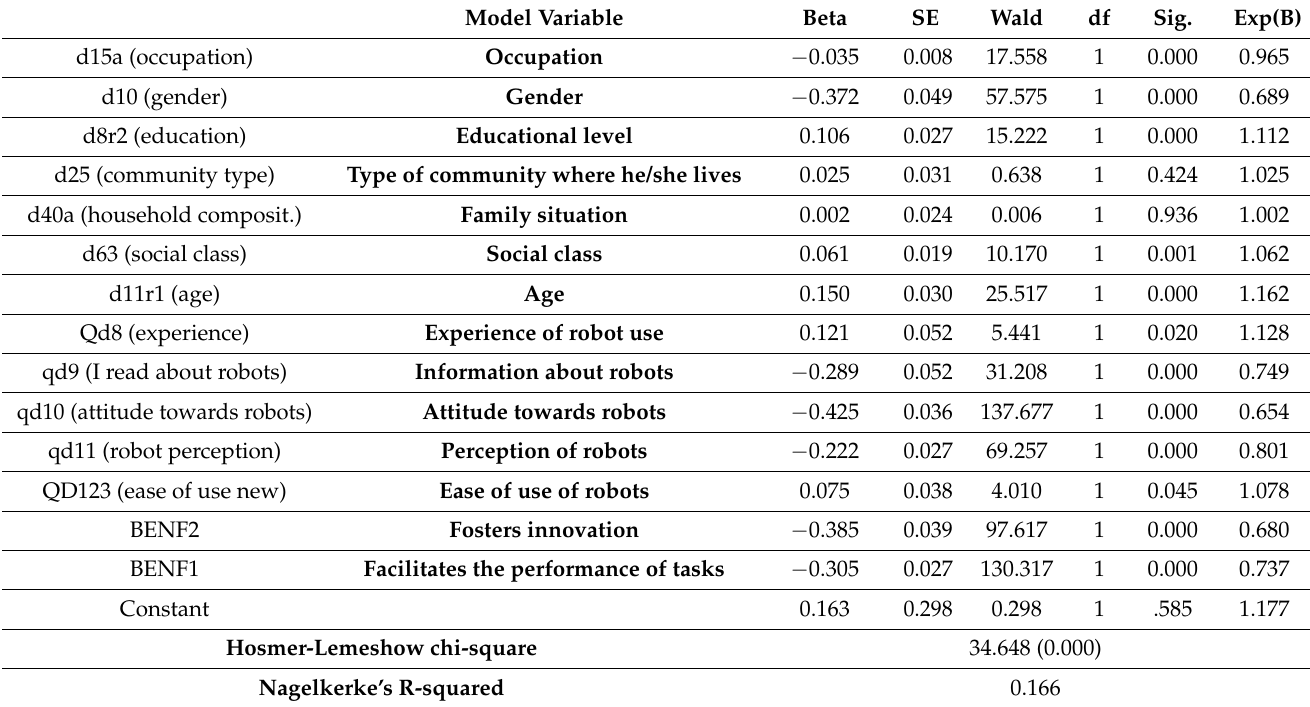
Table 3. Results of logistic regression for the sample as a